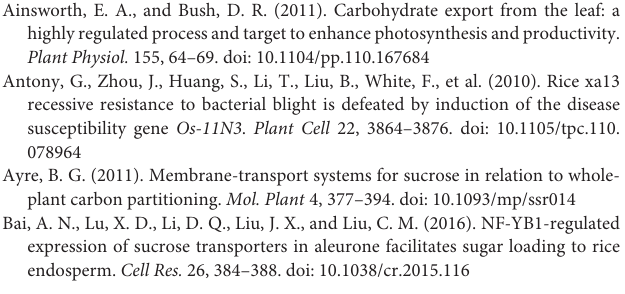
Supplementary Figure 2 | Characterization of the OsSWEET14 Mutant. (A–F) Phenotypes of the OsSWEET14 mutant and WT. (C) 110-day-old plants grown in the greenhouse; (B–F) panicle size and seed size. Scale bar, (A) 10 cm. (B–C) 1 cm Error bars represent SE of at least five samples. ∗ P < 0.05; ∗∗ P < 0.01. Supplementary Figure 3 | Top 20 of pathway enrichment. Supplementary Figure 4 | Expression levels of N assimilation genes relative to OsUBQ5 evaluated at the flowering stage in the leaf blade. Transcript levels of OsNRT1;2 (A) ; OsAMT3;2 (B) ; OsNR (C) ; OsGDH (D) ; OsGS1;1 (E) ; OsGS1;2 (F) ; OsGOGAT1 (G) ; OsGOGAT2 (H) . Each data point represents the mean